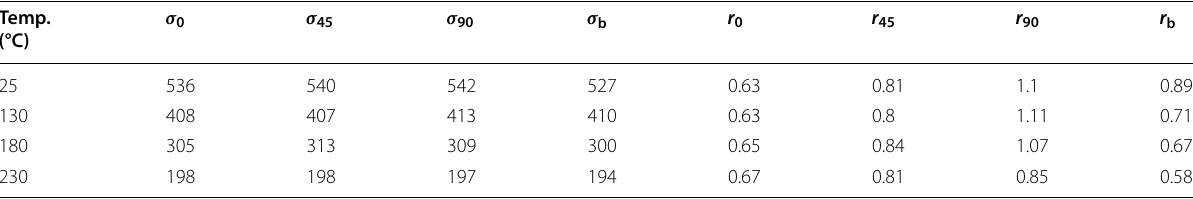
Table 3 Flow stresses and r -values of AA7075-T6 with ε p = 0.002 Temp.